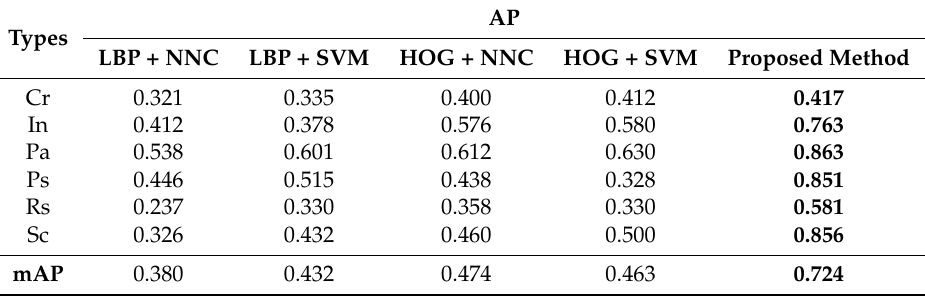
Table 6. Comparison results with traditional methods on NEU-DET dataset. The bold helps to emphasize the highest data.